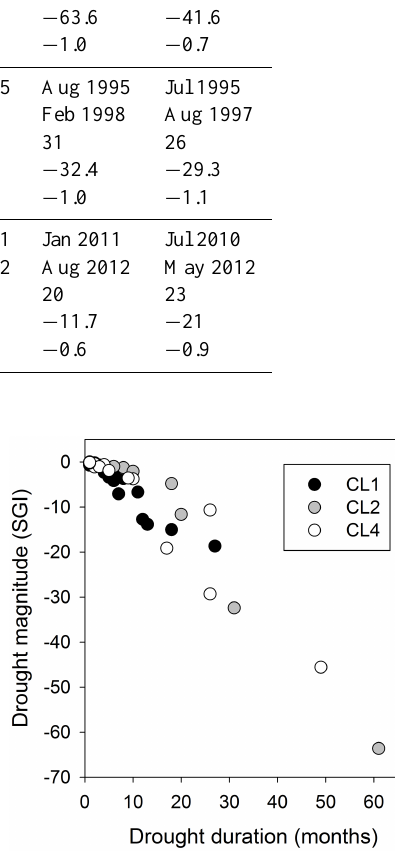
Figure 10. Drought magnitude versus drought duration for sites in clusters CL1, CL2 and